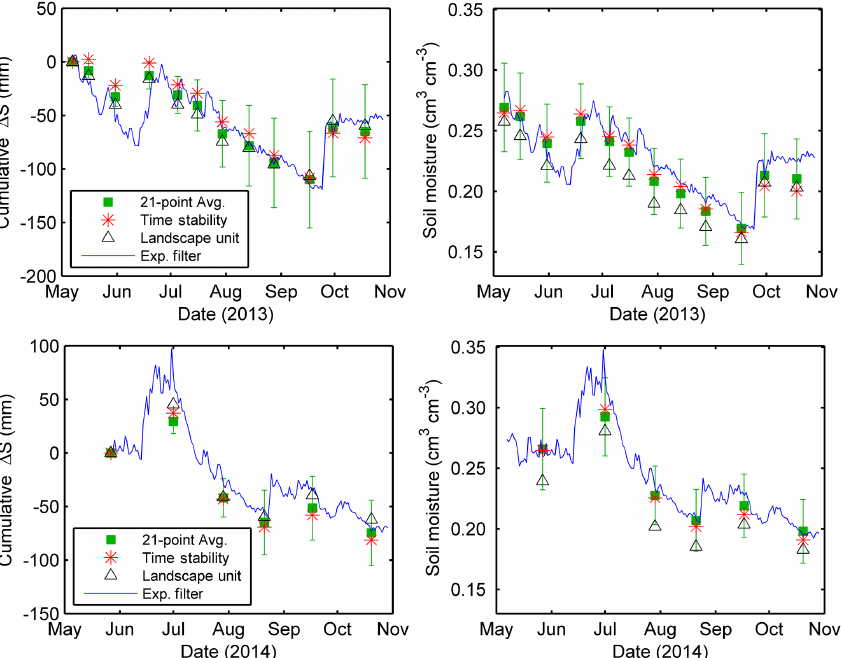
Figure 10. Volumetric water content and cumulative change of field-scale soil moisture as estimated by the depth-scaling methods for 0–110cm in 2013 and 2014.